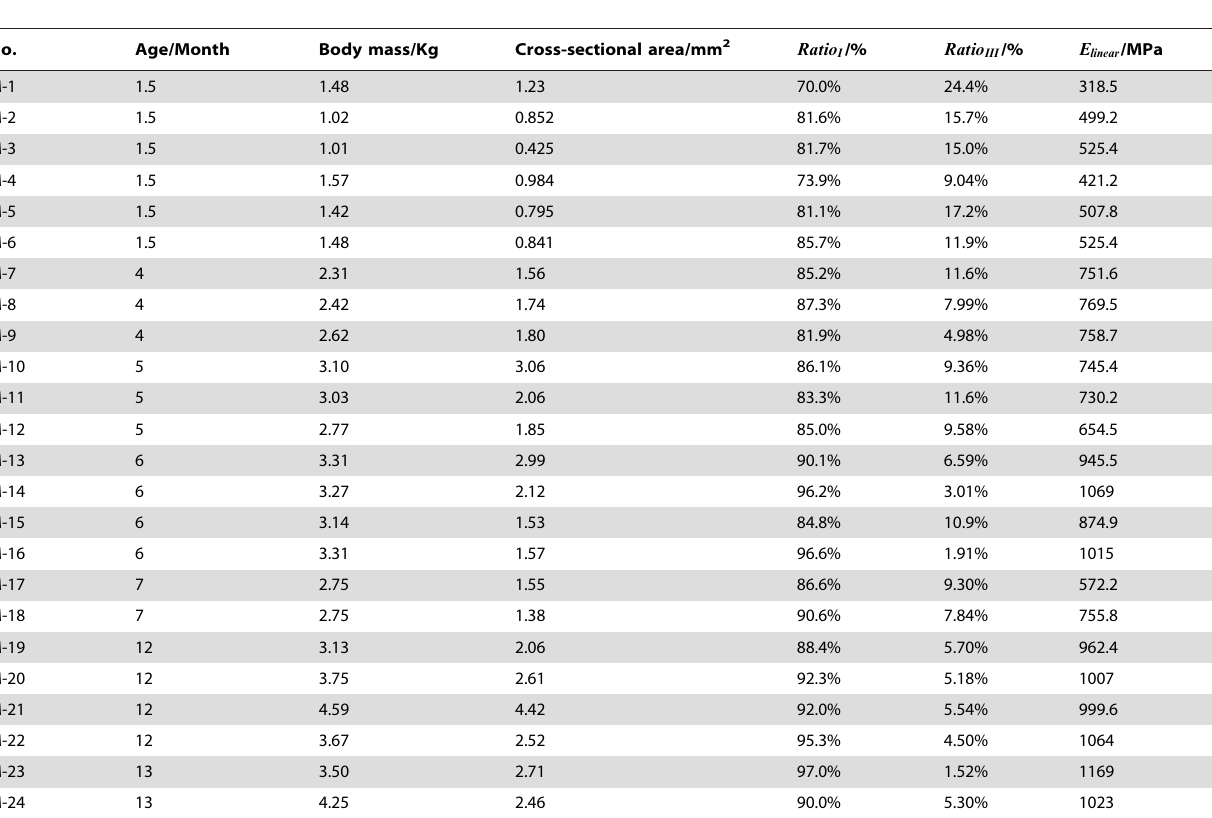
Table 1. The age and body mass of rabbit, and the cross sectional area, collagen contents (ratio of type I collagen, Ratio I , and ratio of type III collagen, Ratio III ) and mechanical property (Young’s modulus in the linear region of the stress-strain curve E linear ) of the mid-substance specimens of